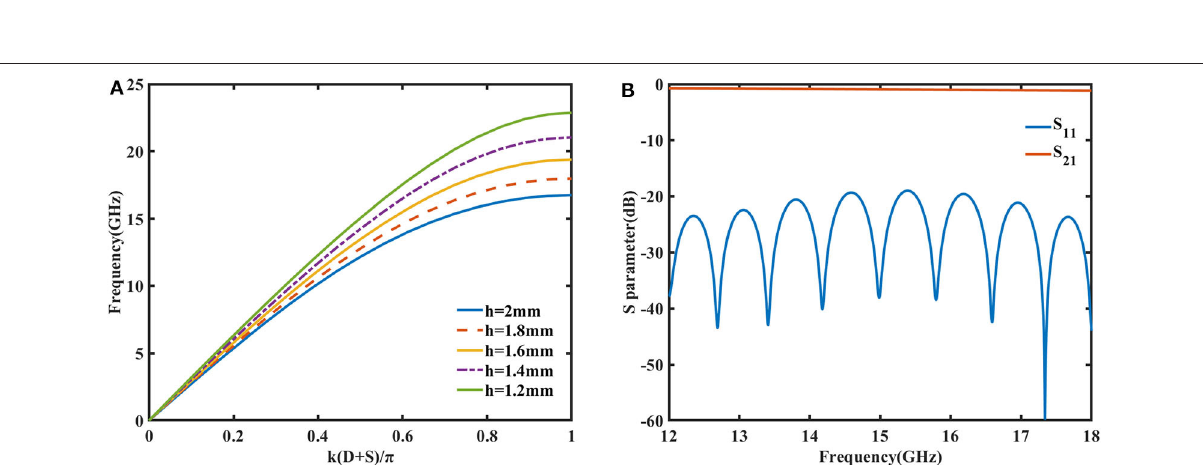
in more loss in metal and dielectric substrate.